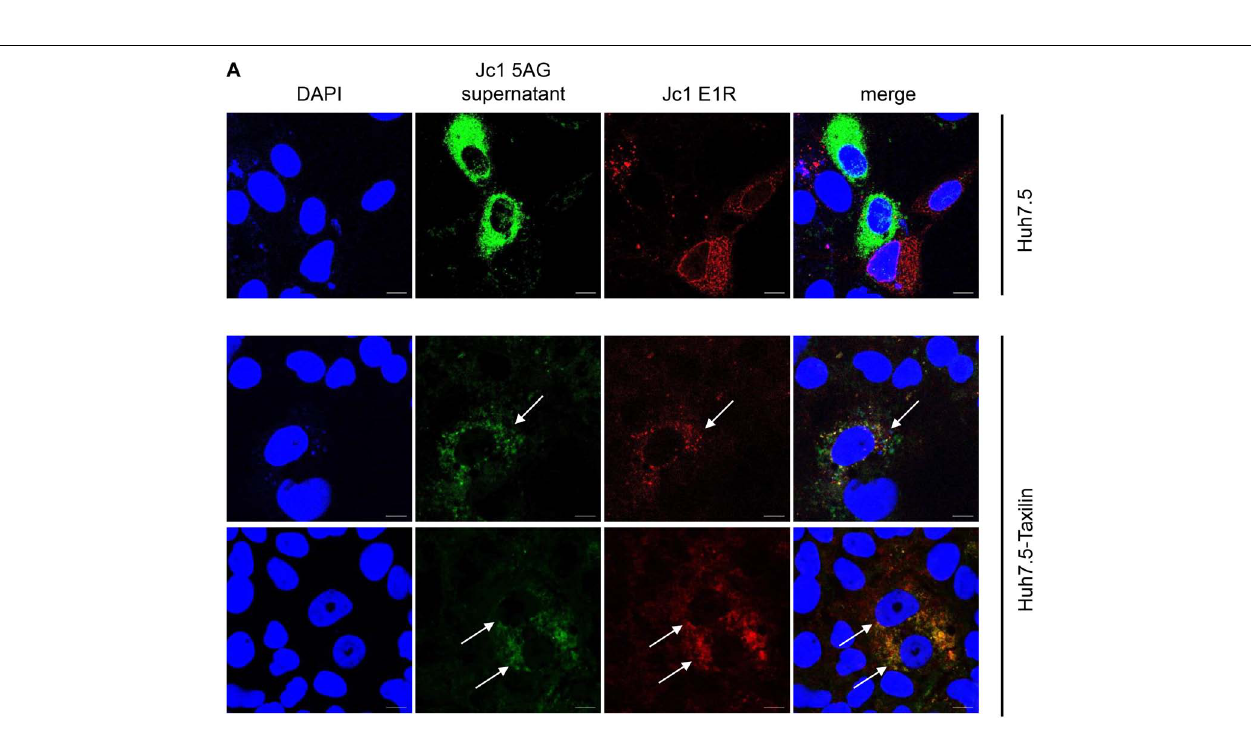
FIGURE 6 | HCV impairs the recycling of the TfR is affected by HCV that can be rescued by α -taxilin overexpression. (A) CLSM analysis of HCV-positive Huh7.5 cells (Jc1), incubated with transferrin-488 (15 µ g/mL) (green) for 1.5 h. After washing of unbound transferrin-488, the cells were immediately fixed or incubated for 10 min at 37 ◦ C to detect the internalized transferrin-488. HCV-positive cells were visualized using a NS5A-specific (red) antibody. Nuclei were stained with DAPI (blue). HCV-positive cell is indicated by a white spotted line and HCV-negative cell is indicated by an orange spotted line. Laser intensity and digital gain were kept constant. Magnifications, x100. The scale bars represent 10 µ m. (B) Quantification of the fluorescence intensity of transferrin-488 in HCV-positive (Jc1) and HCV-negative (GND) Huh7.5 cells after 0 and 10 min incubation ( n = 3, mean ± SEM). Two-tailed unpaired t -test, **** p < 0.0001. (C) CLSM analysis of HCV-positive (Jc1) Huh7.5-Taxilin cells incubated with transferrin-488 (15 µ g/mL) (green) for 1.5 h. After washing of unbound transferrin-488, the cells were immediately fixed or incubated for 10 min at 37 ◦ C to detect the internalized transferrin-488. HCV-positive cells were visualized using a NS5A-specific (red) antibody. Nuclei were stained with DAPI (blue). HCV-positive cell is indicated by a white spotted line and HCV-negative cell is indicated by an orange spotted line. Laser intensity and digital gain were kept constant for untreated cells. Magnifications, x100. The scale bars represent 10 µ m. (D) Quantification of the fluorescence intensity of transferrin-488 in HCV-positive (Jc1) and HCV-negative (GND) Huh7.5-Taxilin cells after 0 and 10 min incubation ( n = 2, mean ± SEM). Two-tailed unpaired t -test, ns = not significant. CLSM analysis of (E) HCV-negative (GND) and (F) HCV-positive (Jc1) Huh7.5 cells, incubated with transferrin-555 (15 µ g/mL) (red) for 1.5 h. After washing of unbound transferrin-555, the cells were immediately fixed or incubated for 10 min at 37 ◦ C to detect the internalized transferrin-555. HCV-positive cells were visualized using a NS5A-specific (green) antibody. Nuclei were stained with DAPI (blue). Laser intensity and digital gain were kept constant. Magnifications, x100. (G) Quantification of the fluorescence intensity of transferrin-555 in HCV-negative (GND) and HCV-positive (Jc1) Huh7.5 cells after 0 and 10 min incubation. Total fluorescence per cell was calculated using ImageJ software and the following formula: corrected total cell fluorescence (CTCF) = integrated density - (area of selected cell × mean fluorescence of background readings). In total, a minimum of 10 cells were measured (mean ± SEM). Two-tailed unpaired t -test, ** p < 0.01, **** p < 0.0001. (H) Impaired uptake of iron ions in HCV-positive Huh7.5 cells (Jc1) compared to HCV-negative cells (GND) 72 hpe. The intracellular amount of Fe 2 + was determined using a Cobas 8000 system ( n = 3; mean ± SEM). Two-tailed unpaired t -test, * p <